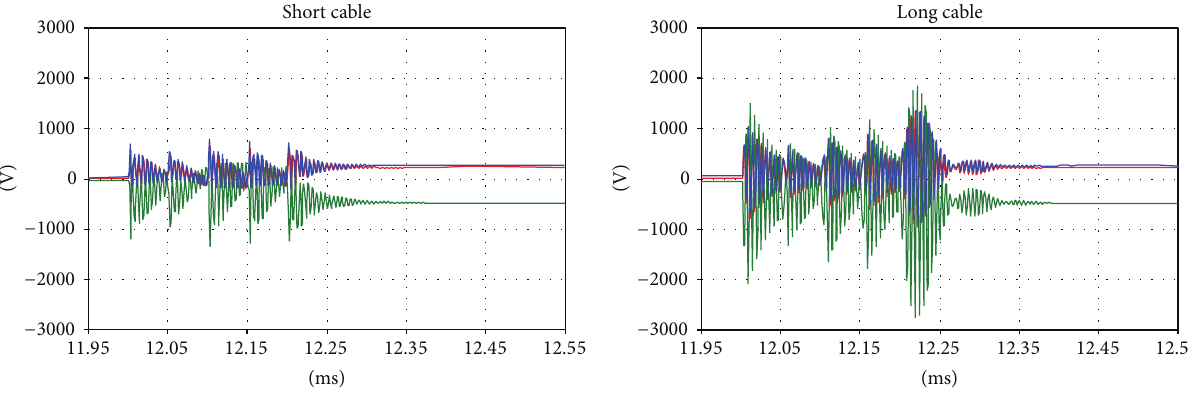
Figure 18: The transient voltages in the tap coil during the inrush.